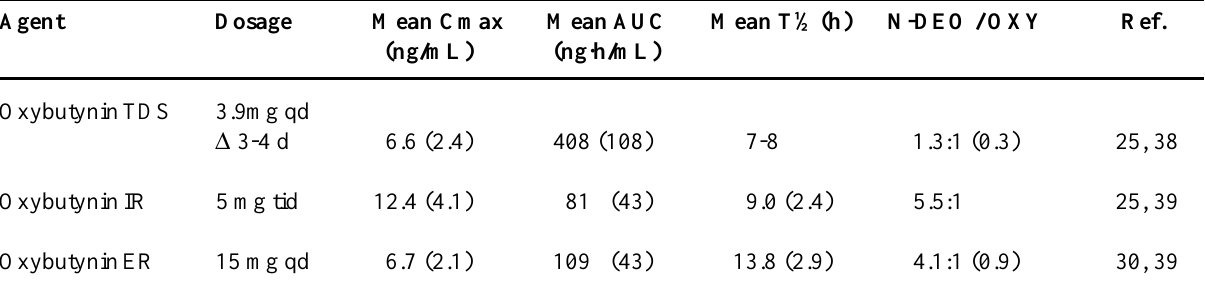
Table 2 – Comparative steady state pharmacokinetic parameters of oxybutynin immediate-release (IR), oxybutynin extended- release (ER), and oxybutynin transdermal